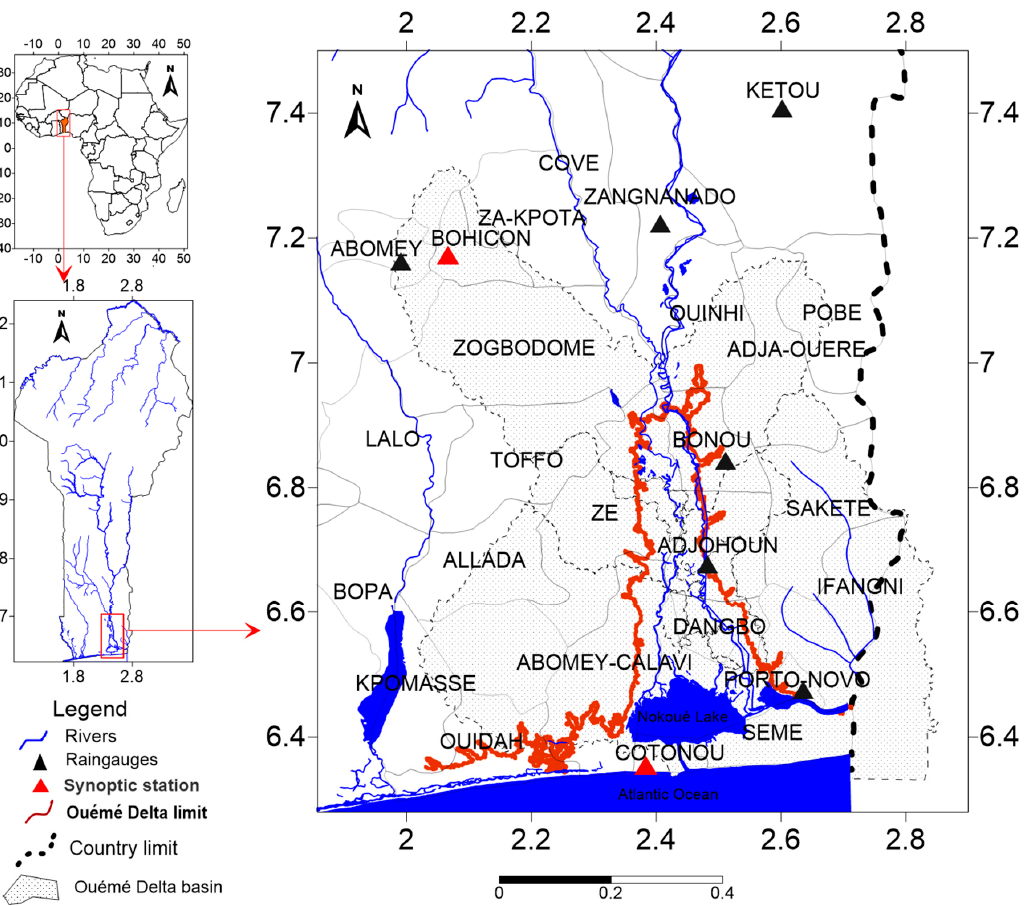
Figure 1. Ouémé Delta geographical position. Figure 1. Ou é m é Delta geographical position.